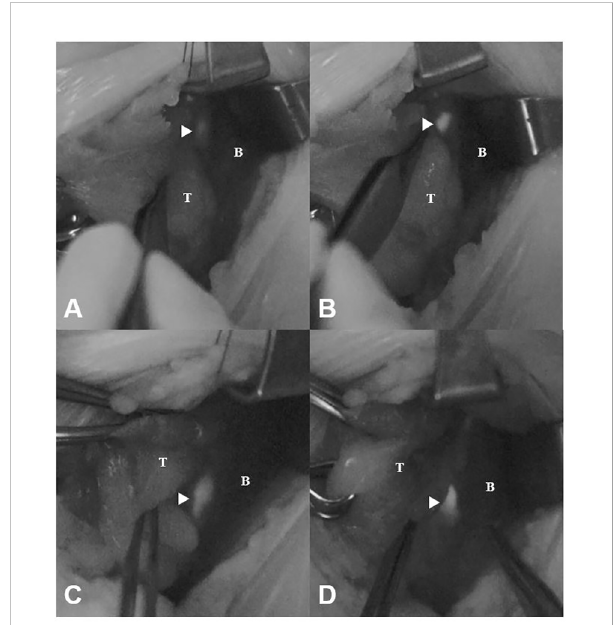
FIGURE 2 Faint and bright NIRAF images of unexposed and exposed PGs (arrowheads). (A) Faint image before dissection (NIRAF intensity: 2.15 au). (B) Faint image after dissection (NIRAF intensity: 4.01 au). (C) Bright image before dissection (NIRAF intensity: 3.33 au). (D) Bright image after dissection (NIRAF intensity: 4.77 au). T, thyroid; B, background; NIRAF, near-infrared auto fl